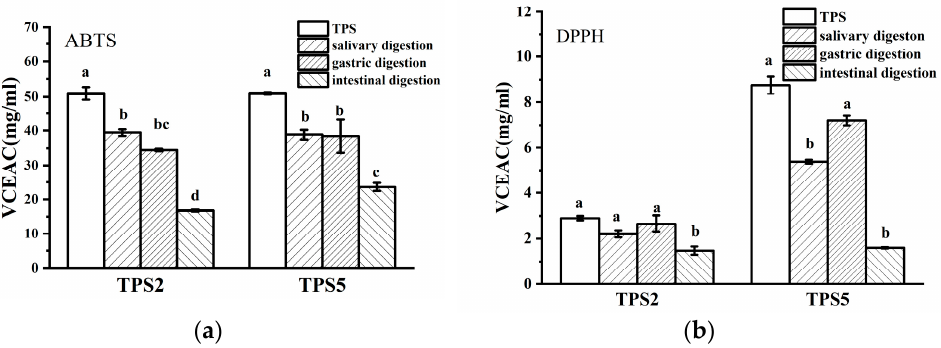
Figure 3. Radical scavenging ability of ABTS ( a ) and DPPH ( b ) of TPS2 and TPS5 in simulated digestion. Different letters indicate significant difference ( p < 0.05).